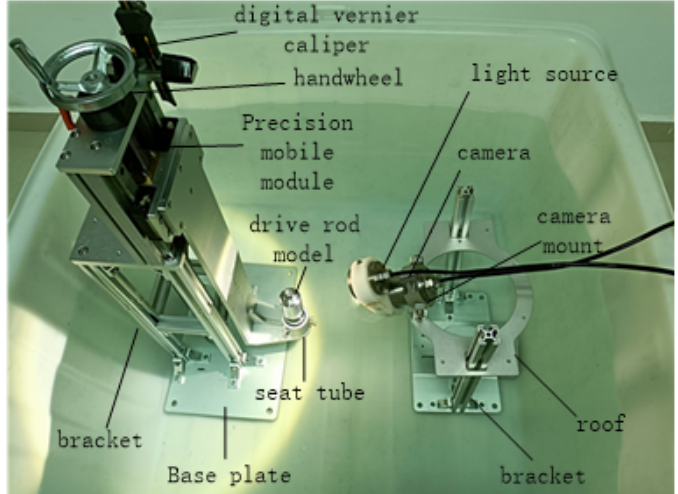
Figure 3. Experimental platform and physical drawing.